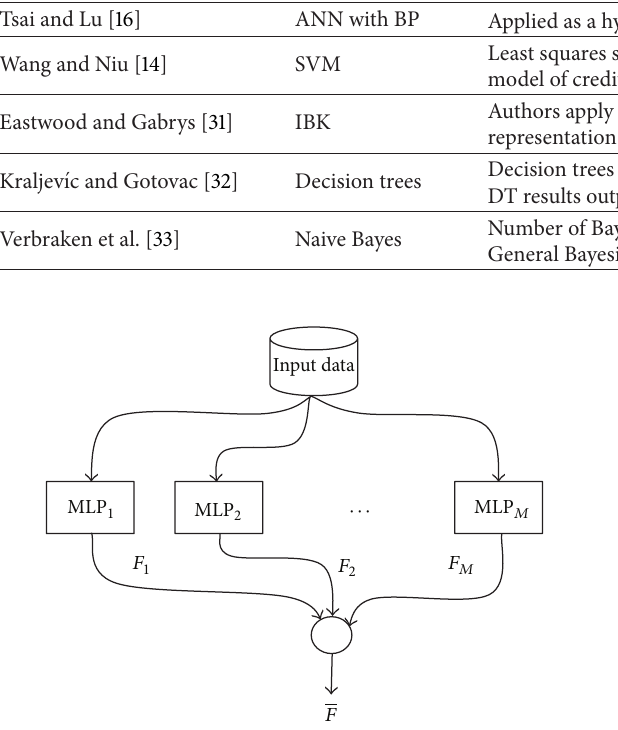
Figure 1: Ensemble of MLP